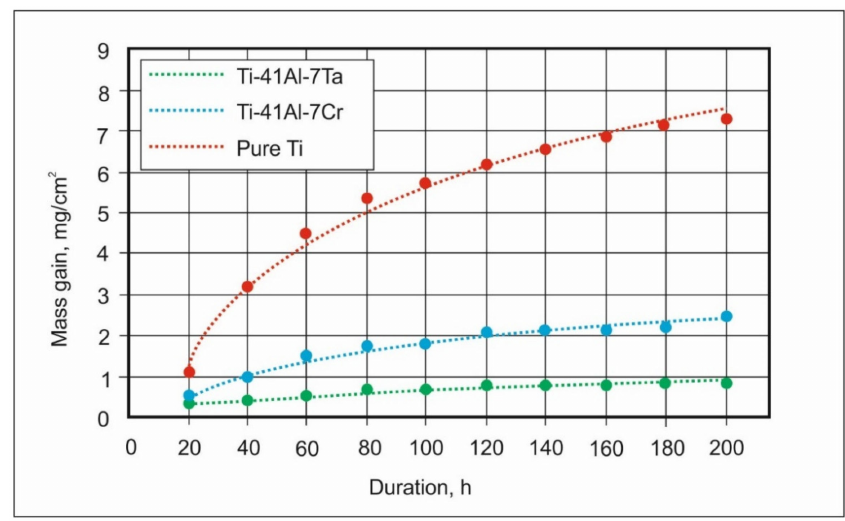
Figure 8. Mass gain during oxidation tests at 800 ◦ C for 200